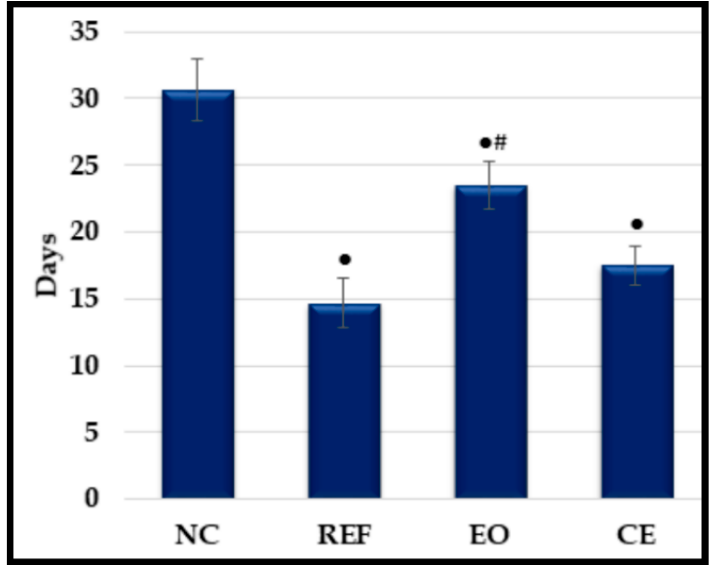
Figure 4. Effect of Fucidin cream (REF), essential oil (EO), and chloroform extract (CE) creams of Commiphora gileadensis on the percentages of wound contractions in rats.